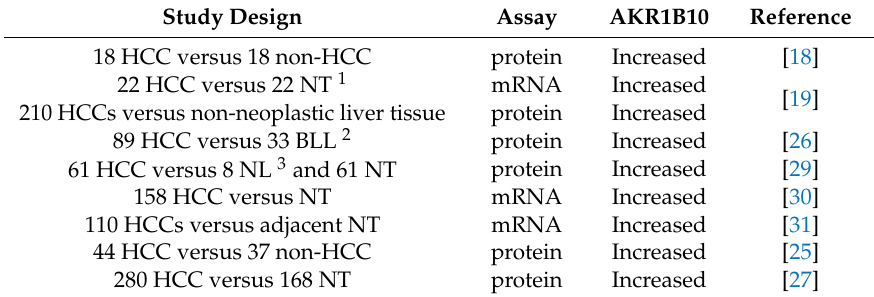
Table 1. AKR1B10 expression patterns in Hepatocellular carcinoma